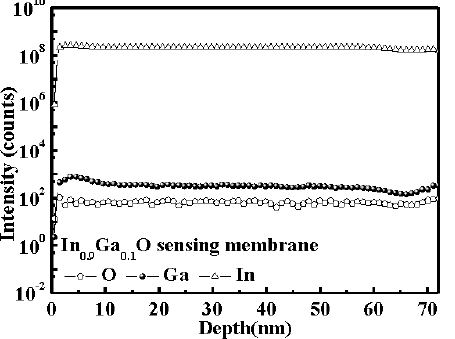
Figure 4. The SIMS profile of the In 0.9 Ga 0.1 O sensing membrane.